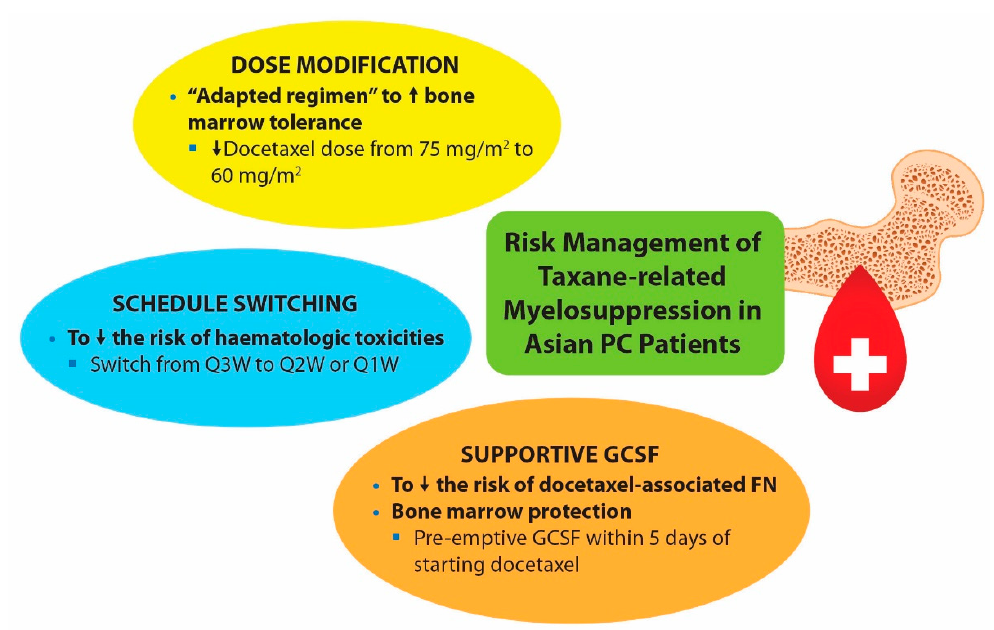
Figure 2. Strategies for reducing the risk of taxane-related myelosuppression in Asian prostate cancer (PC) patients. GCSF, granulocyte colony-stimulating factor; FN, febrile neutropenia.